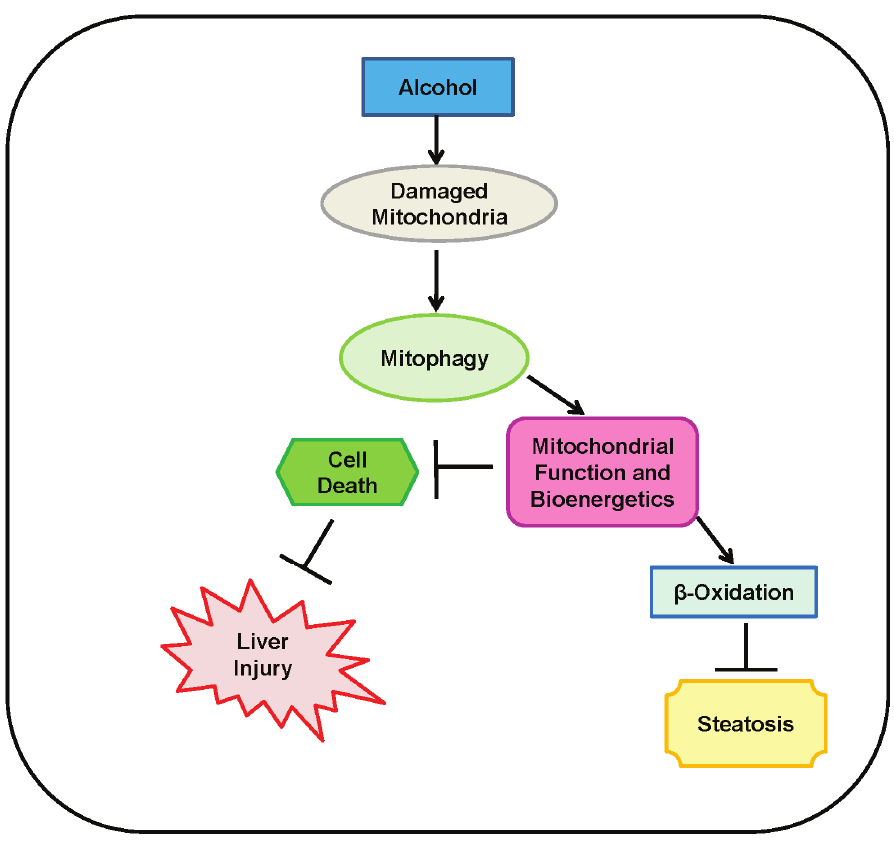
Figure 1. Mitophagy protects against alcohol-induced liver injury and steatosis. Alcohol initiates mitochondrial damage and dysfunction, which causes liver injury and steatosis. Mitophagy protects against liver injury and steatosis by removing these damaged and dysfunctional mitochondria, which maintains mitochondrial function and bioenergetics to avoid alcohol-induced cell death and liver injury. In addition, maintenance of a healthy mitochondria population by mitophagy allows for efficient (cid:3)-oxidation, which reduces alcohol-induced liver steatosis. Two perpendicular lines represent “inhibition of”, and arrows represent “promotion